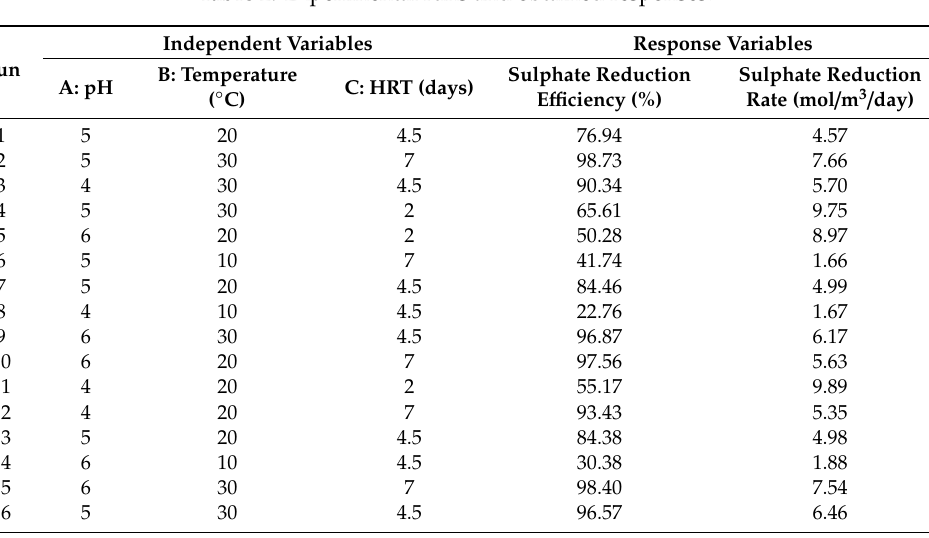
Table 2. Experimental runs and obtained